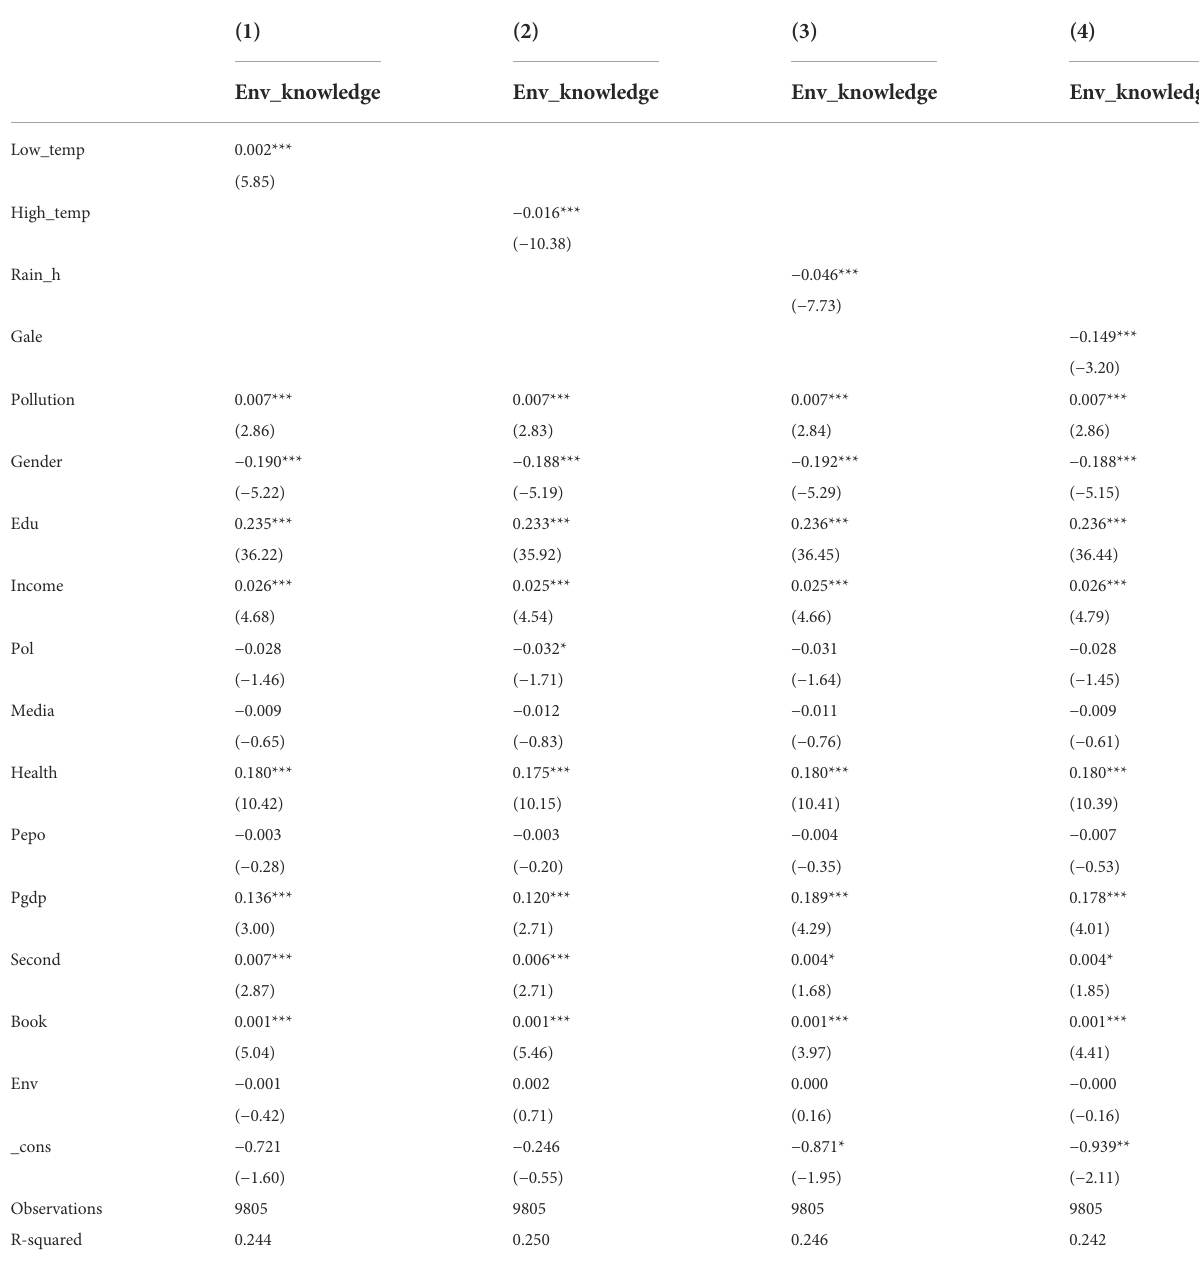
TABLE 13 Mechanism test — environmental